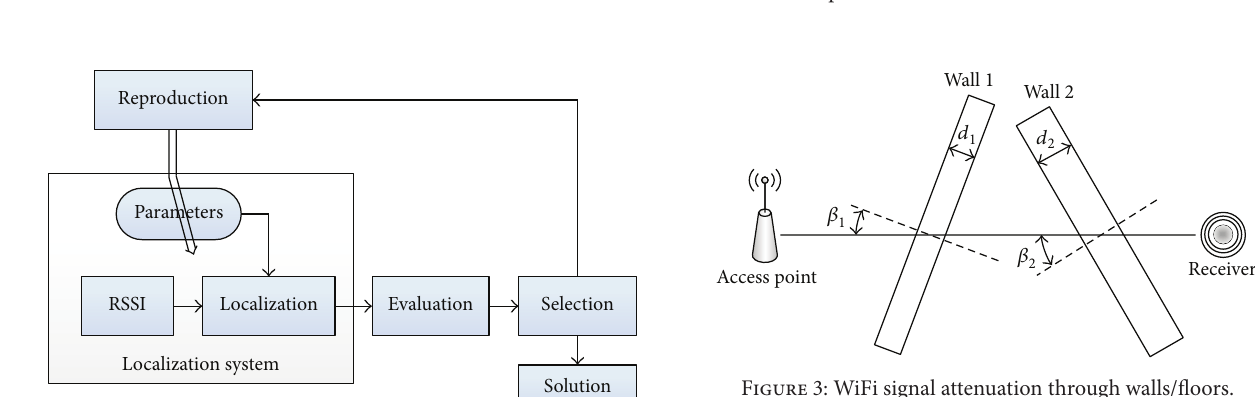
Figure 1: General architecture of localization platform.